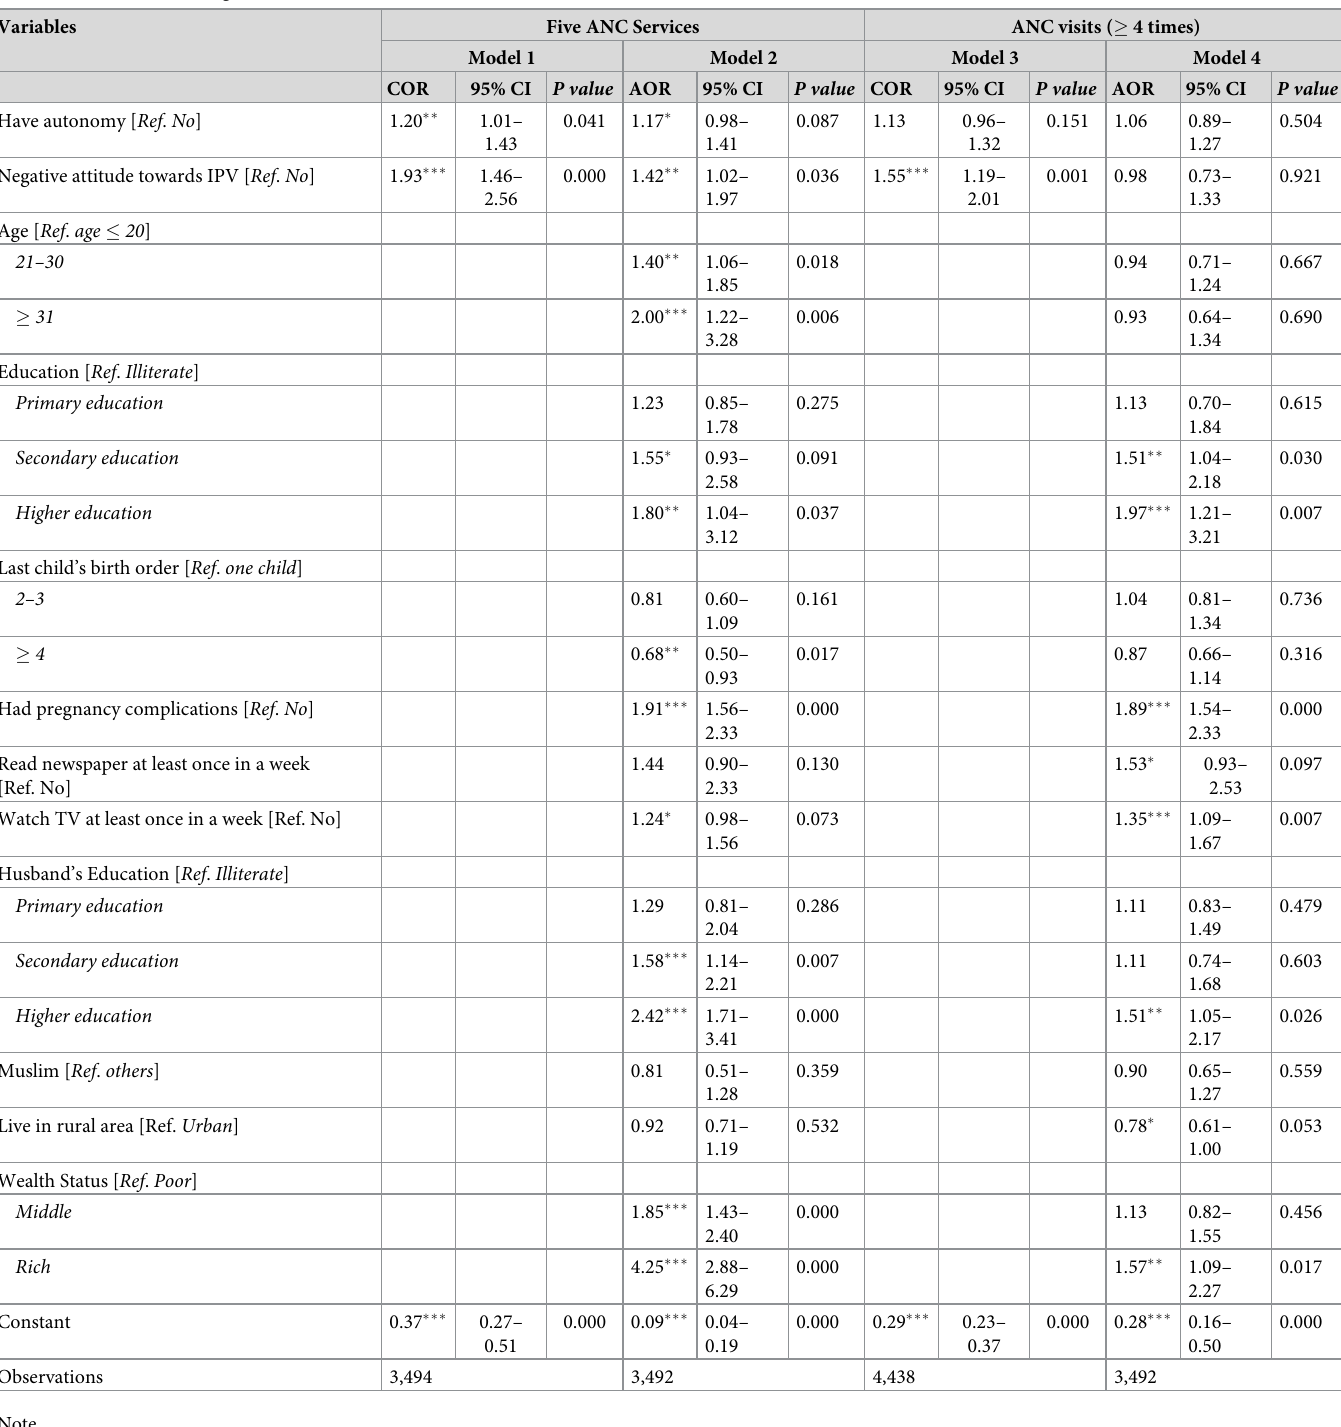
Table 2. Factors influencing access to and utilization of five ANC services and ANC